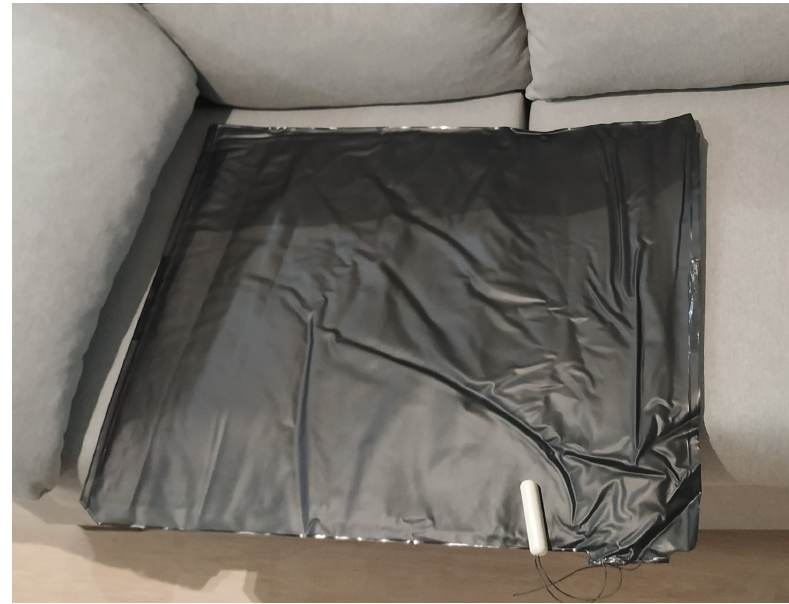
Figure 9. Arun PM3 & Door/Window